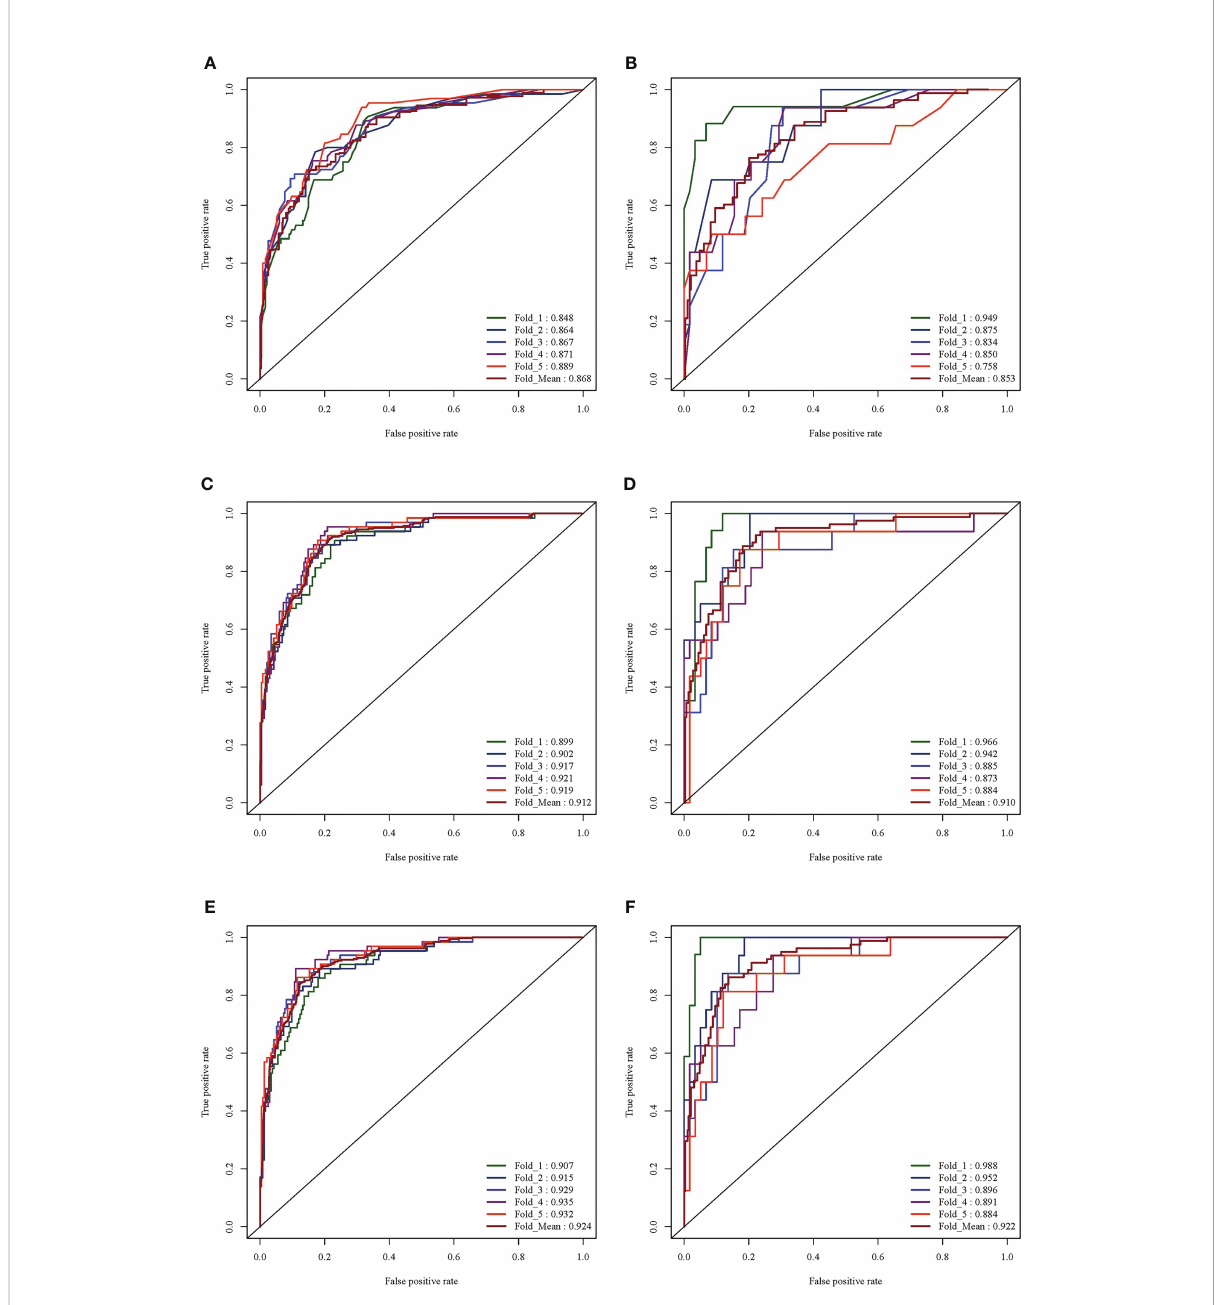
FIGURE 4 ROC curve analysis results of the three models. (A) ROC curve of Radiological model in training set (average AUC = 0.889). (B) ROC curve of Radiological mode in validation set (average AUC = 0.758). (C) ROC curve of Radiomics mode in training set (average AUC = 0.919). (D) ROC curve of the Radiomics model in the validation set (average AUC = 0.884). (E) ROC curve of the R-R model in the training set (average AUC = 0.932). (F) ROC curve of the R-R model in the validation set (average AUC =